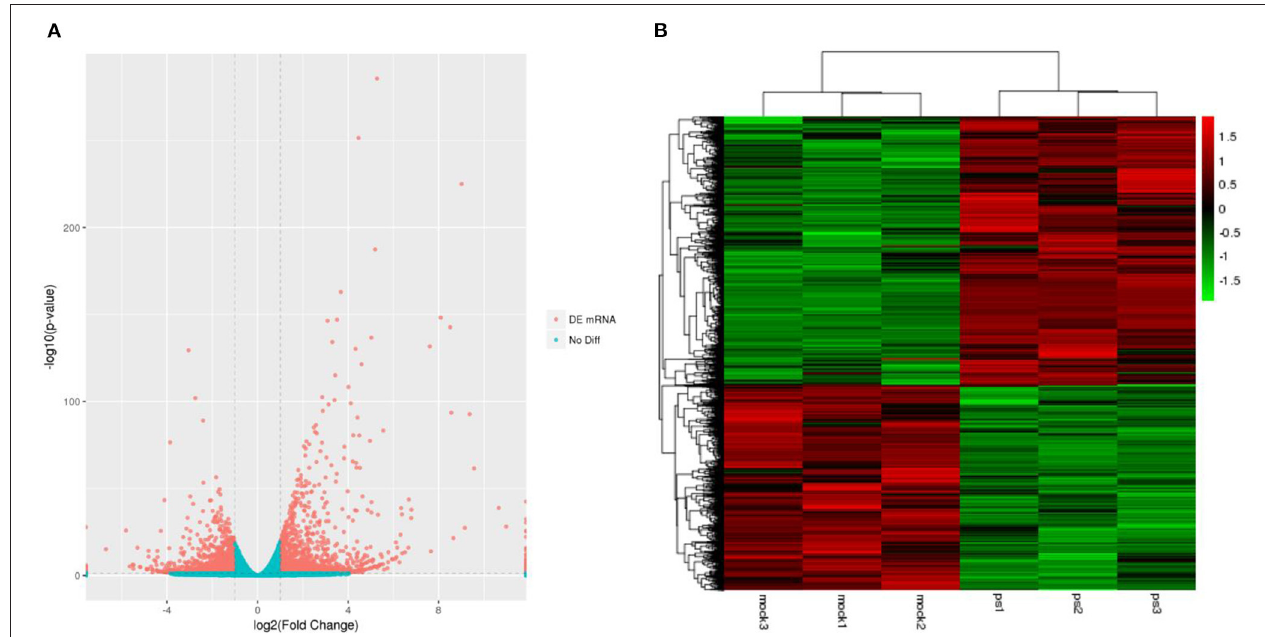
FIGURE 1 | The expression profiling of mRNAs in the CDV-infected and control groups. (A) The volcano plot displaying the distribution of differentially expressed genes in infected groups compared with the uninfected group. Red dots indicate significantly upregulated genes and blue dot is no significantly different mRNAs. (B) Heat map showing the hierarchical clustering of mRNAs that are common to the six samples. Red and green indicate higher and lower expression in Mv. l. Lu cells, respectively. The color scale was the normalized count.